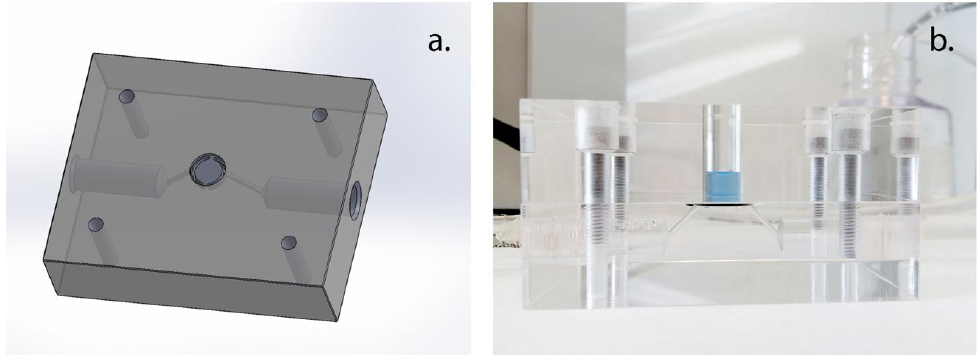
Figure 2. Forward osmosis operating module with static top compartment. ( a ) Showing the drawings of the lower unit where the peptide sample was recirculated and ( b ) showing the assembled module.